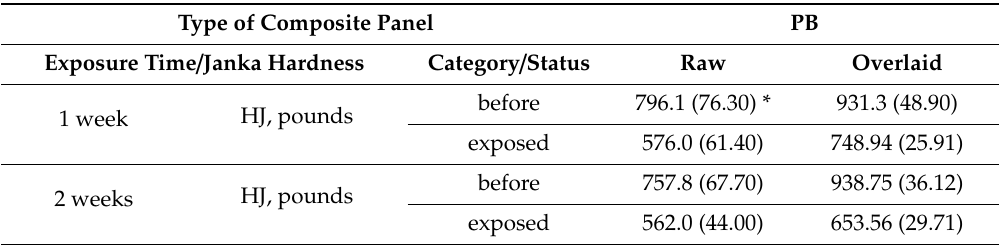
Table 4. Average values of hardness of the particleboard samples before and after exposure to humidity